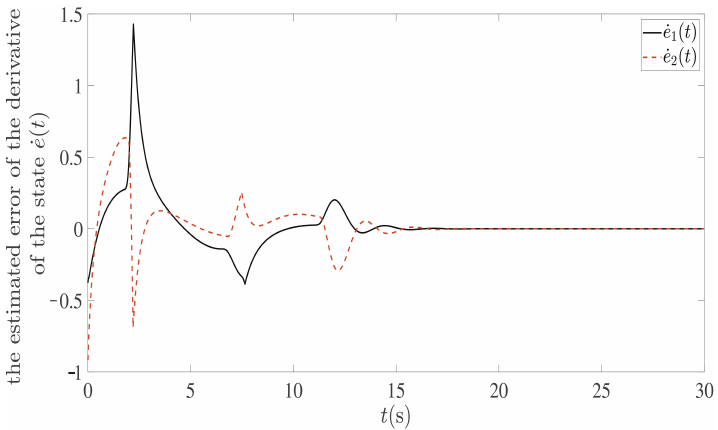
Figure 8. The error curves of the derivative of the